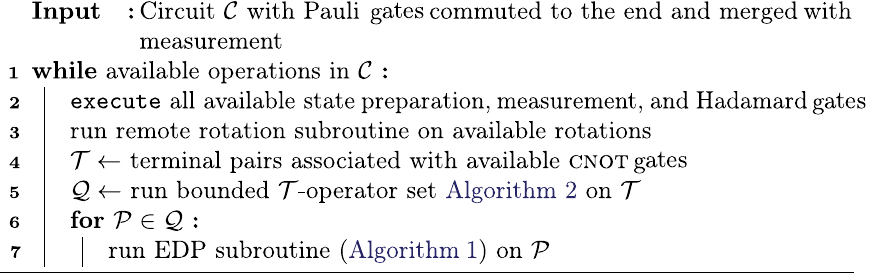
(Algorithm 4) combines the bounded T -operator